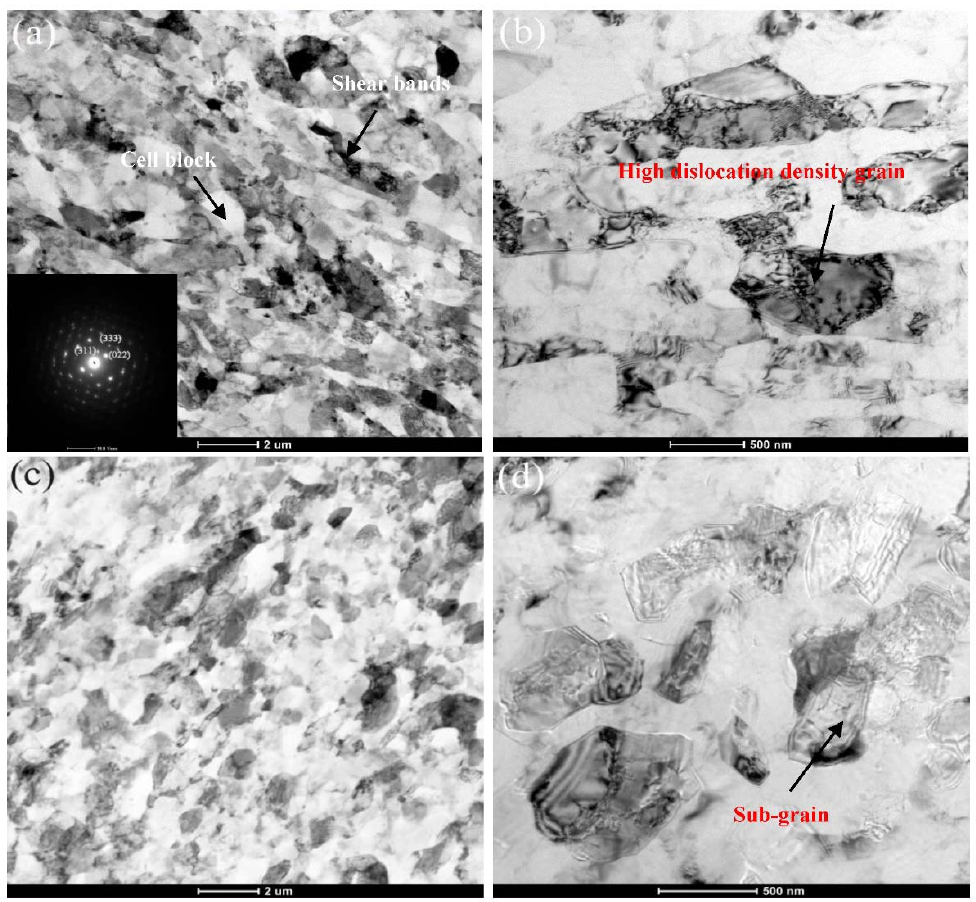
Figure 7. The TEM images showing general microstructure of Al ‐ 6061 alloy in the deformed stated processed by MEM and MEE. ( a , b ) Al ‐ 6061 alloy processed by MEM; ( c , d ) Al ‐ 6061 alloy processed by MEE.